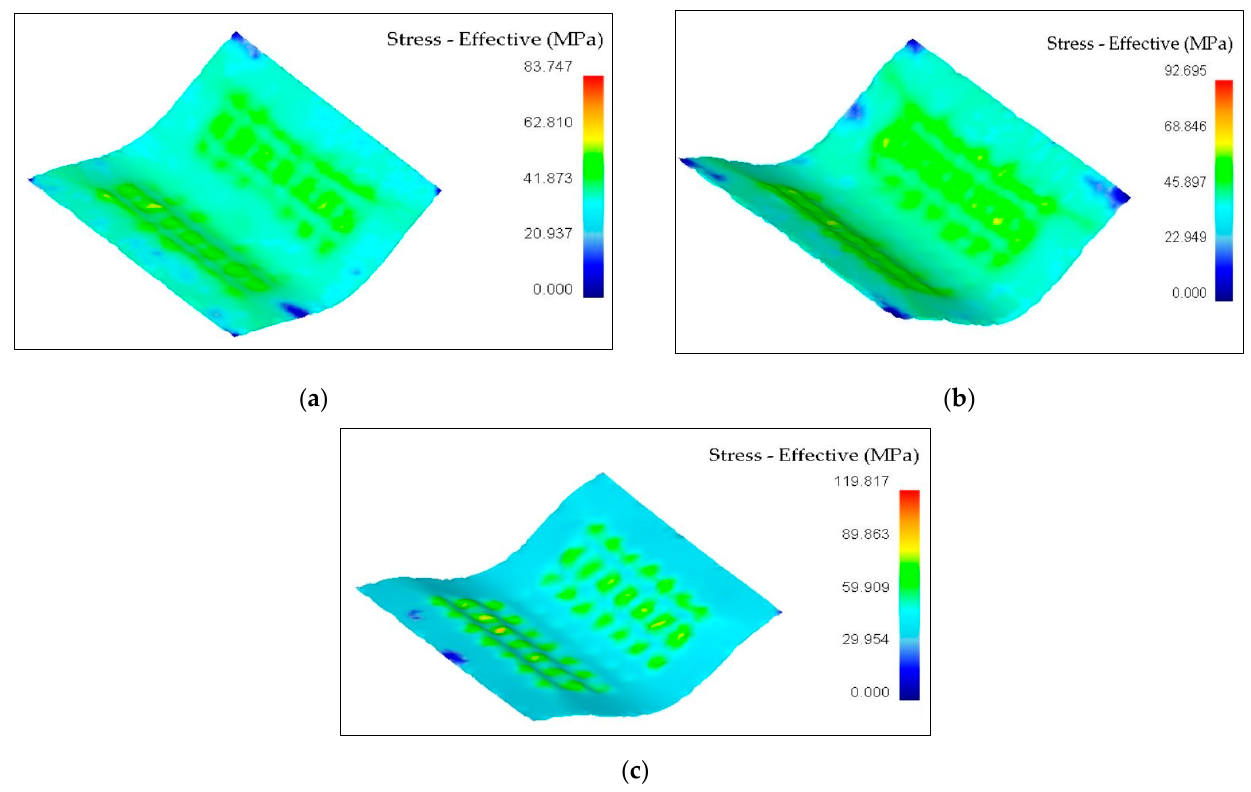
Figure 8. Effective stress distribution of form1 with a pin diameter of ( a ) 10 mm; ( b ) 12 mm; ( c ) 14